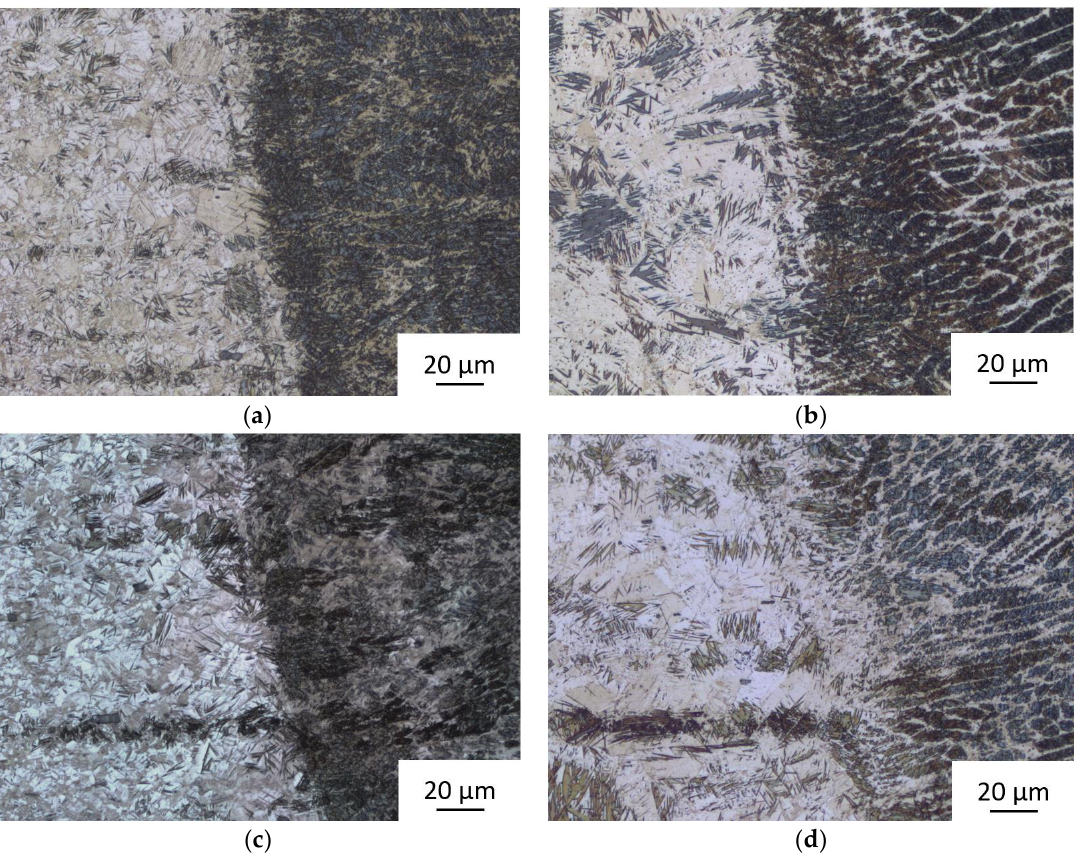
Figure 8. The fusion border between the weld metal and the heat-affected zone in the welded sheets: ( a ) T15-81c (cold-rolled condition); ( b ) T15-81a (annealed condition); ( c ) T15-82c (cold-rolled condition); and, ( d ) T15-82a (annealed condition).